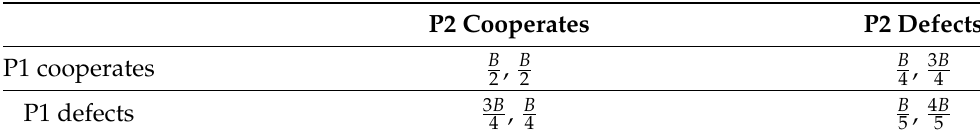
Table 2. The Payoff Matrix for P1 and the